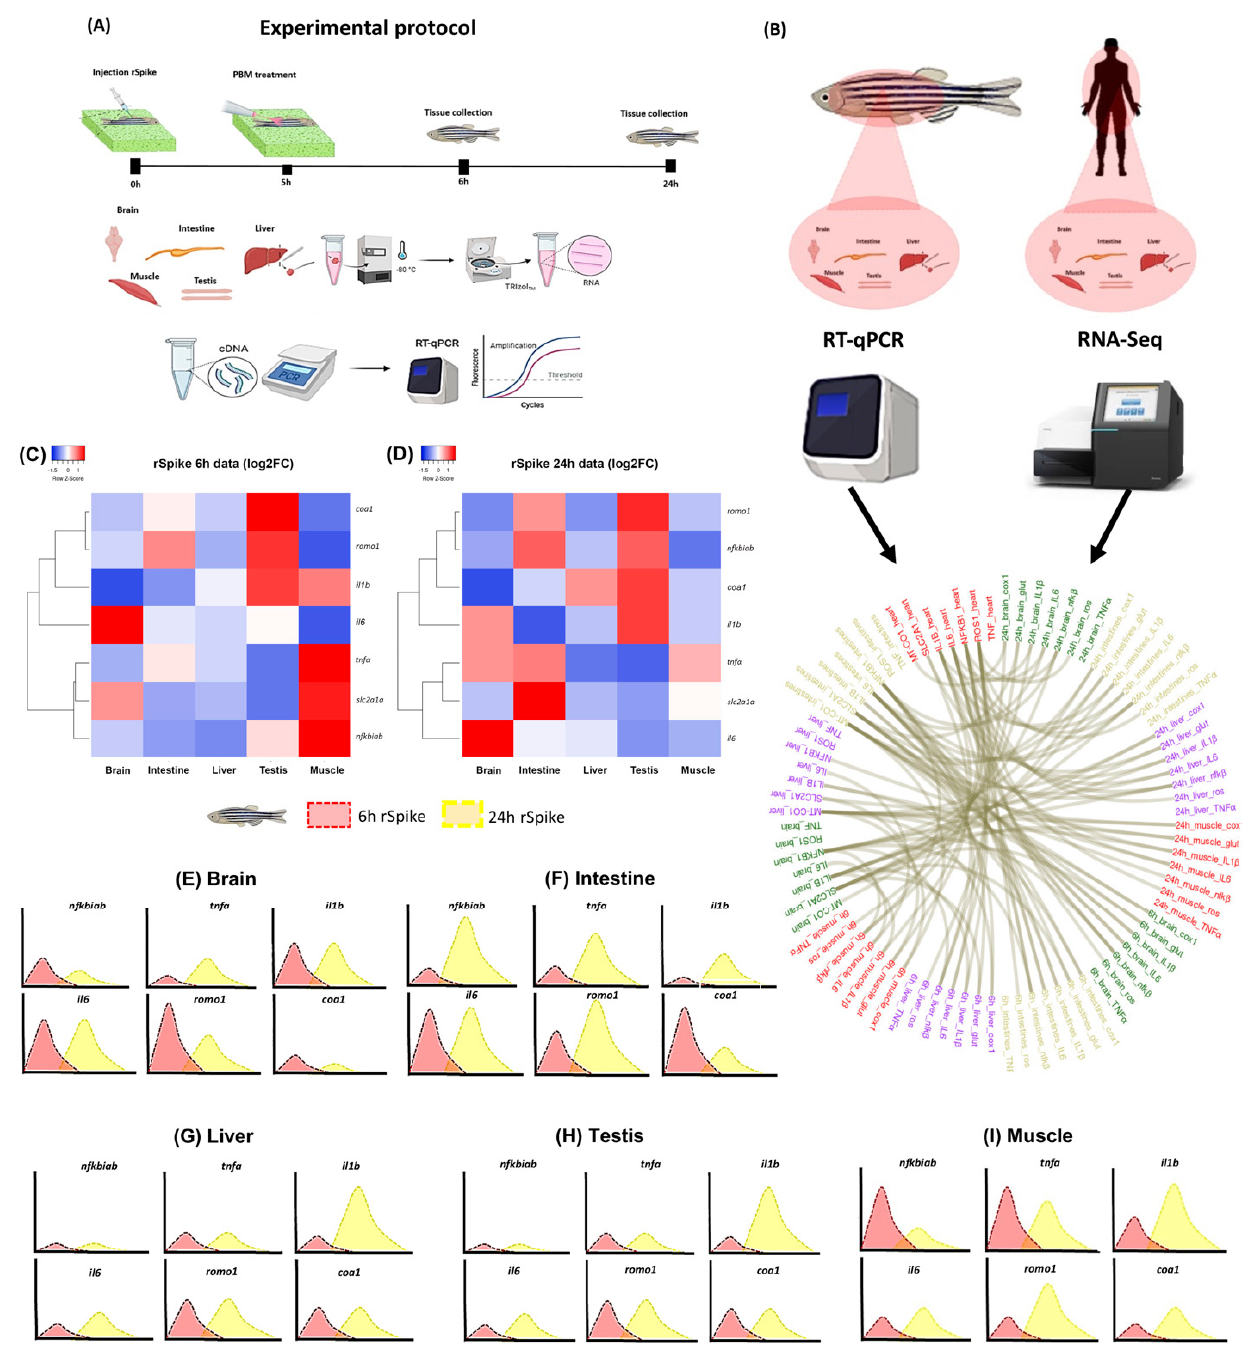
Figure 1. Overview of the transcriptional signature of COVID-19-associated cytokine storm syndrome in a zebrafish model. ( A ) Experimental protocol; ( B ) Chord diagram of the transcriptional signature and evolution of fold-change in the rSpike group in different tissue with the comparison of RNA-seq expression analysis in human tissue with COVID-19 ( n = 30) versus without COVID-19 ( n = 36) (from data set); ( C ) Heatmap illustrating the fold-change of relative expression levels of related genes in the brain, intestine, liver, testis, and muscle treated with rSpike at 6 h; ( D ) Heatmap illustrating the fold-change of relative expression levels of related genes in the brain, intestine, liver, testis, and muscle treated with rSpike at 24 h; Curve chart illustrating the relative expression levels of genes in ( E ) the brain, ( F ) intestine, ( G ) liver, ( H ) testis, and ( I ) muscle. The x -axis represents the different times (red 6 h and yellow 24 h), and the y -axis represents each gene’s relative expression.